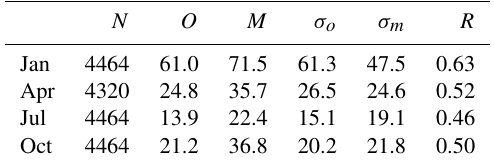
Table 3. Statistical summary of the comparisons of the monthly average SO 2 between simulation and